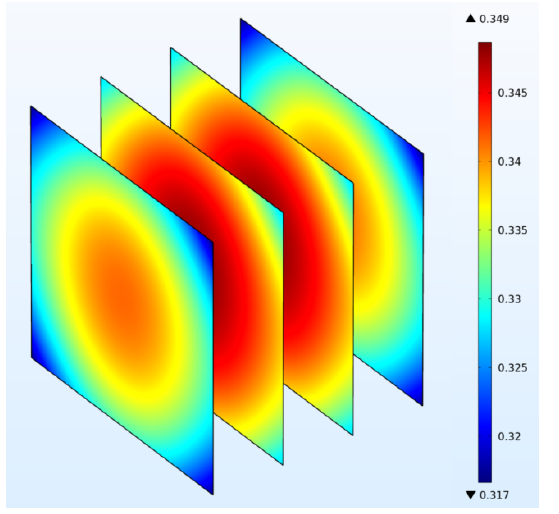
Figure 8. Distribution of water concentration (mg ∙ cm − 3 ) in potato samples from simulation ( t = 12 h).